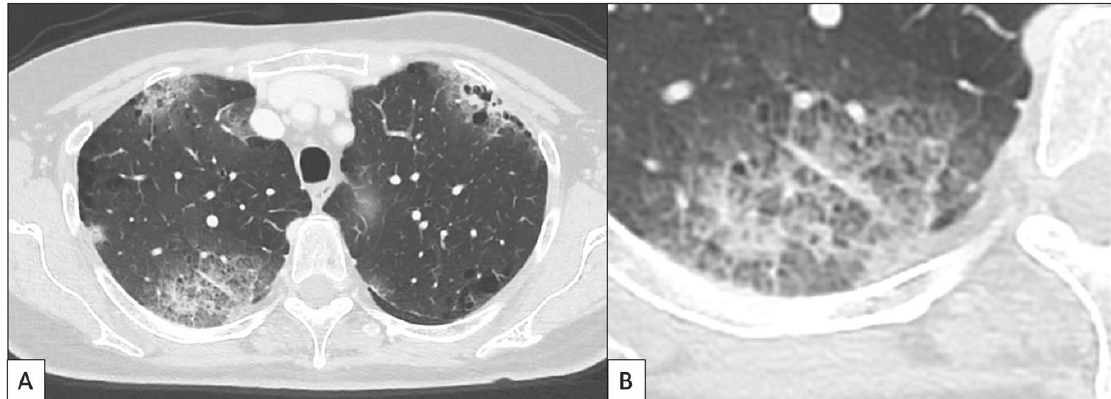
Table 3. Suggested criteria for diagnosis of